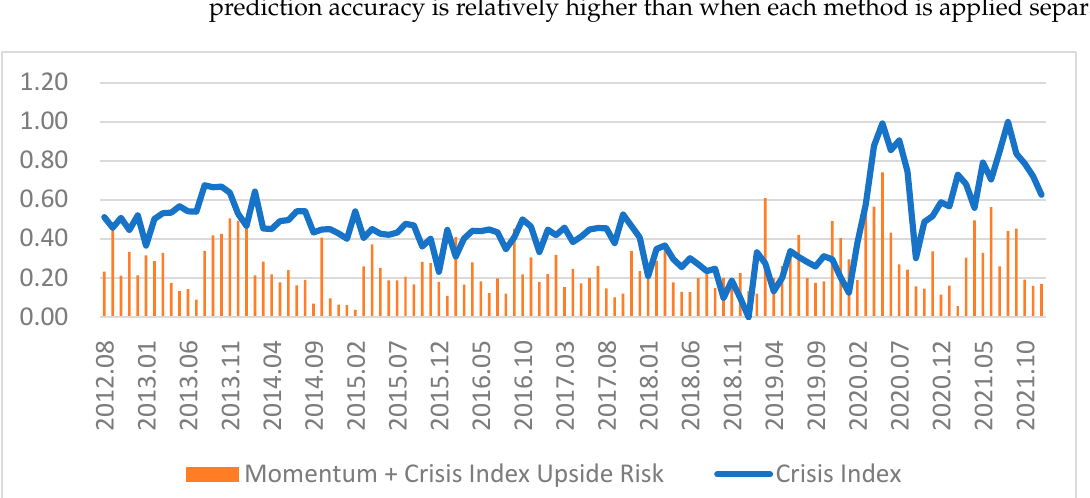
Figure 7. Comparison of Crisis Index Trends and Crisis Prediction Models in the Energy Industry.